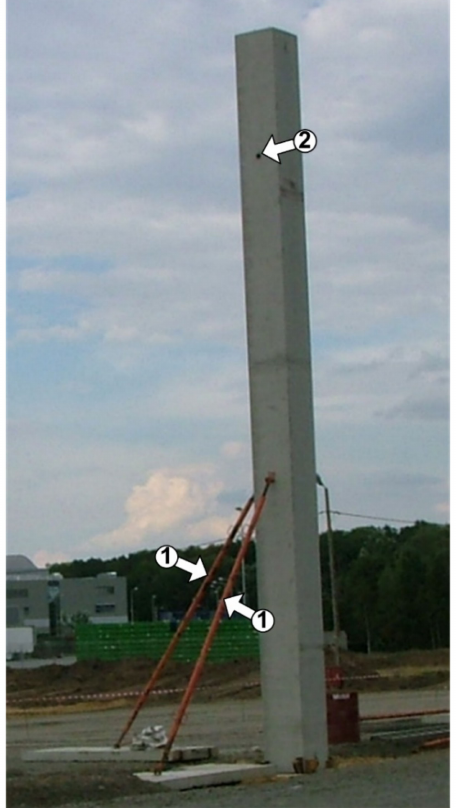
Figure 13. View of wedged and supported column; 1—column supports, 2—place where the hooks of the special sling were placed during the installation of the